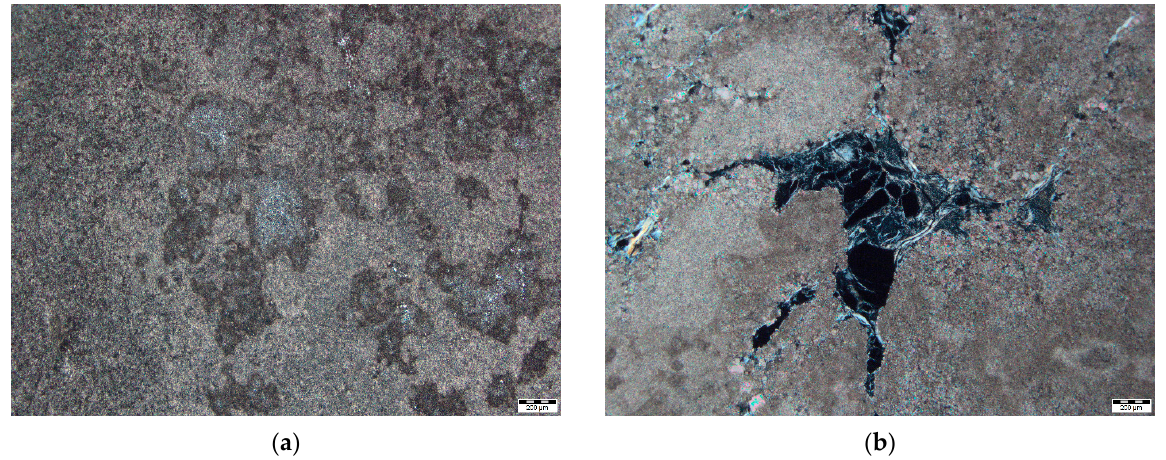
Figure 3. Magnesite from the Szklary deposit. ( a ) Rock pores filled with magnesite cement and dark-colored areas pigmented with iron compounds. ( b ) Karst pores partially filled with minerals from the serpentine group, sparite crystals of magnesite.